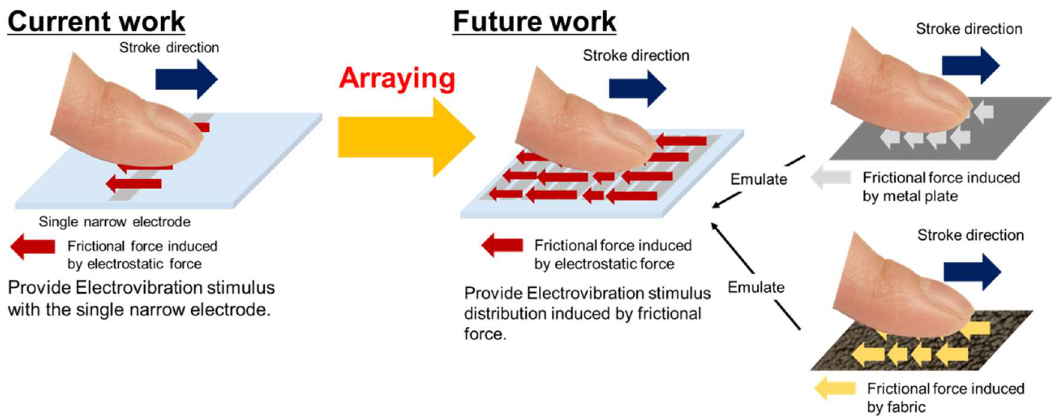
Figure 1. Concept of the multi-electrode electrovibration tactile display. The presented frictional force is spatially changed via voltage control, as shown on the right side. The multi-electrode electrovibration tactile display has a potential to emulate frictional force distribution of real materials. The objective of this study is the evaluation of the single narrow electrode, as shown on the left side.